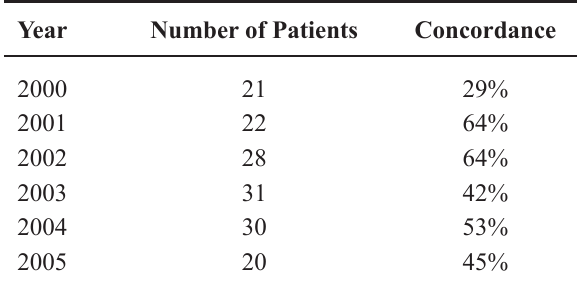
Table 4 – Gleason concordance per